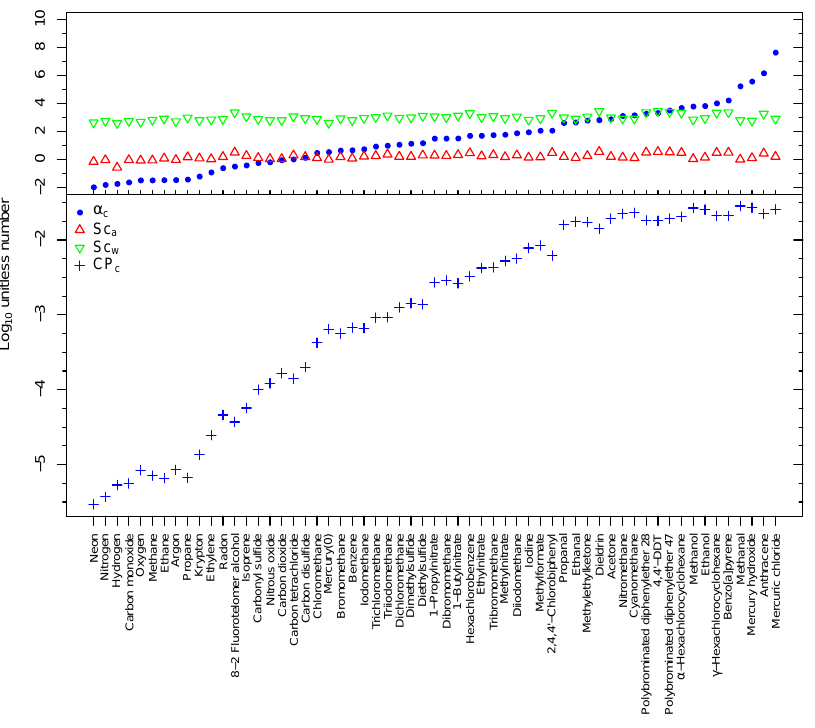
Fig. 4. The chemical parameter, CP c , computed as in Eq. (34), for chemicals having a range in aqueous solubility at 20 ◦ C. Additional assumptions are stated in the text. CP c can be multiplied by AP 0 x (Fig. 3) to obtain the required sensor resolution for a given flux measurement method. Dimensionless solubility and Schmidt numbers in air and water are shown for